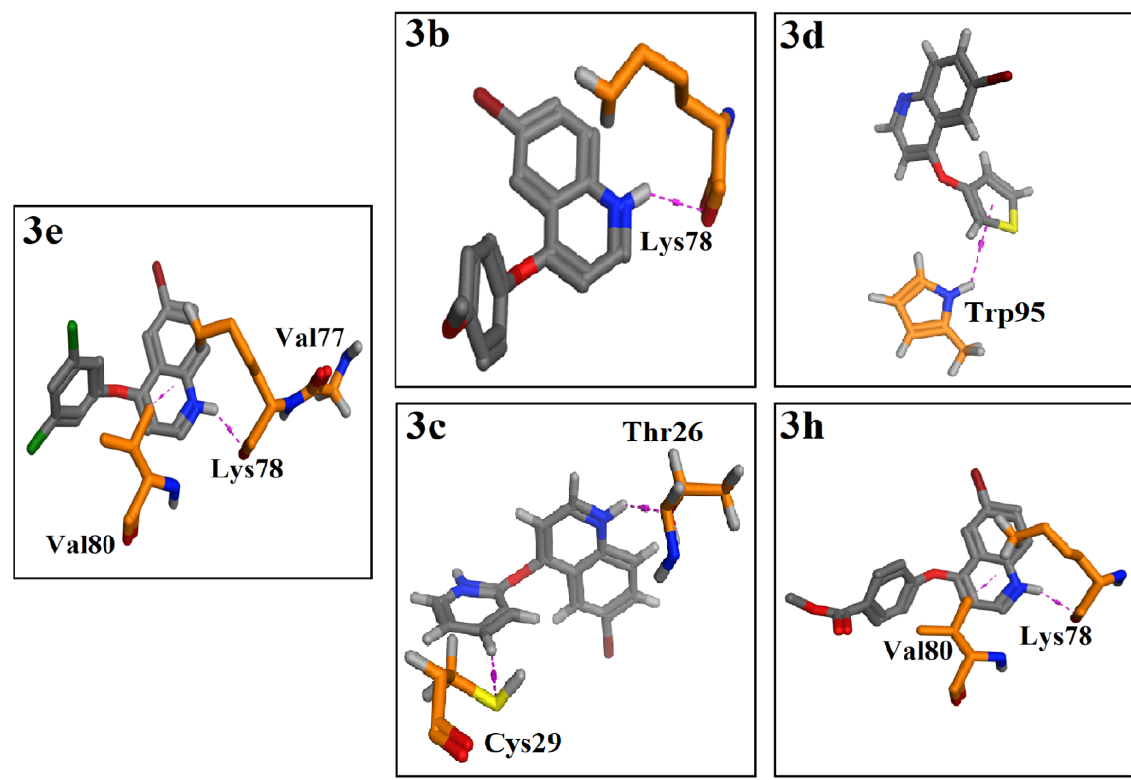
Figure 5. Protein–ligand contacts of highly active 3e , moderately active 3c and 3h , and least active 3b and 3d within the active site of 2Y2T receptor.